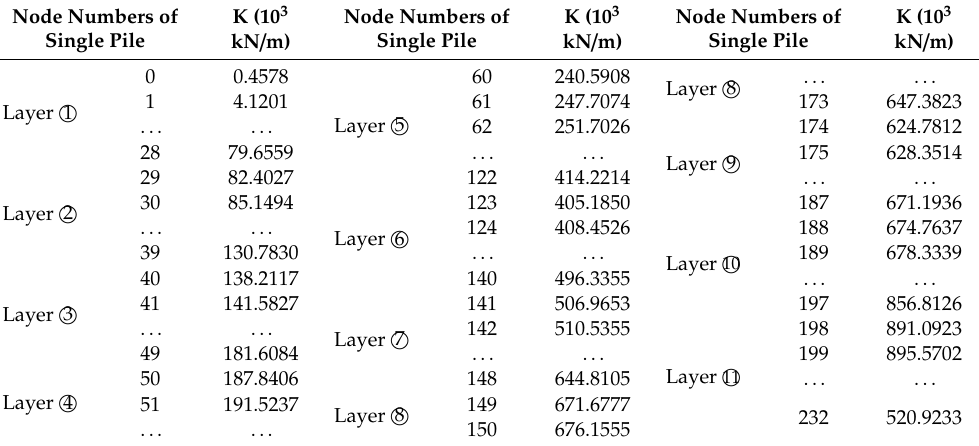
Table 7. Updated sti ff ness of soil springs after the iteration